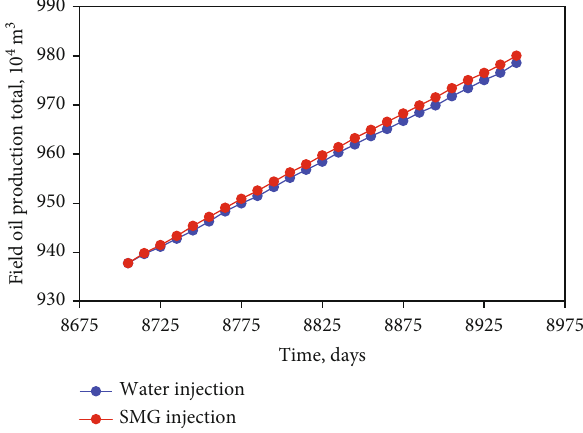
Figure 19: Change in cumulative oil production after microgel injection.